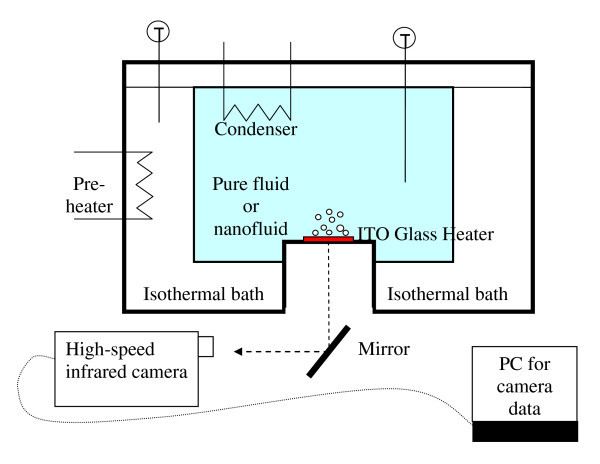
MIT pool boiling facility with infrared thermometry.